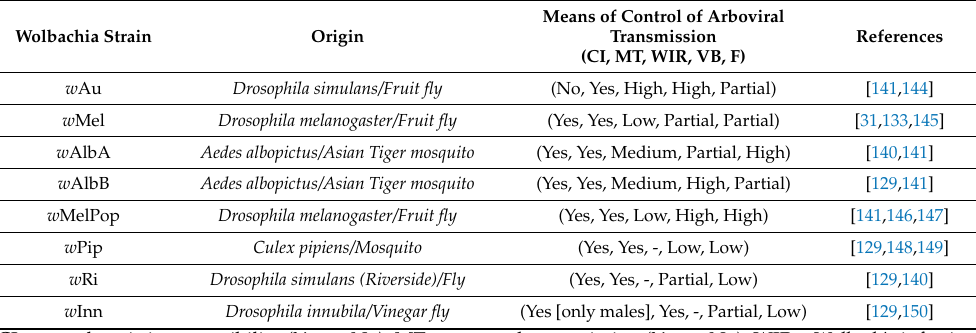
Table 2. Description of different Wolbachia strains, the arthropod (origin) in which they were found and the presence of the means of control of arboviral transmissions Wolbachia